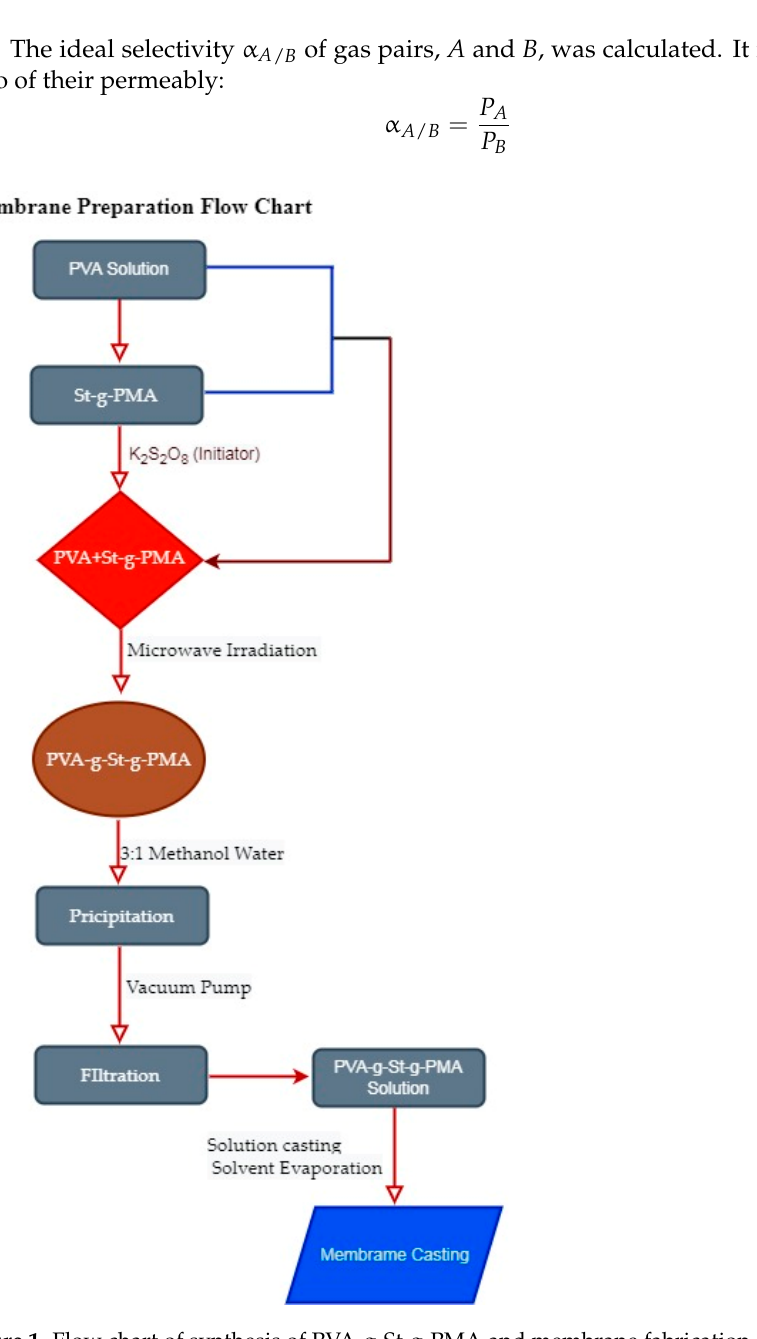
Figure 1. Flow chart of synthesis of PVA-g-St-g-PMA and membrane fabrication.